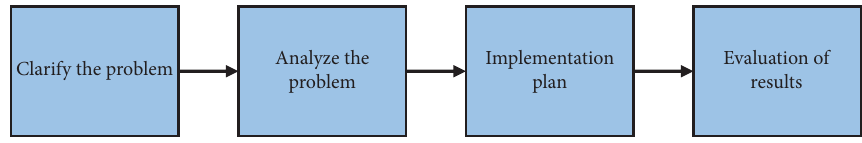
Figure 1: Flow of student behavior analysis.